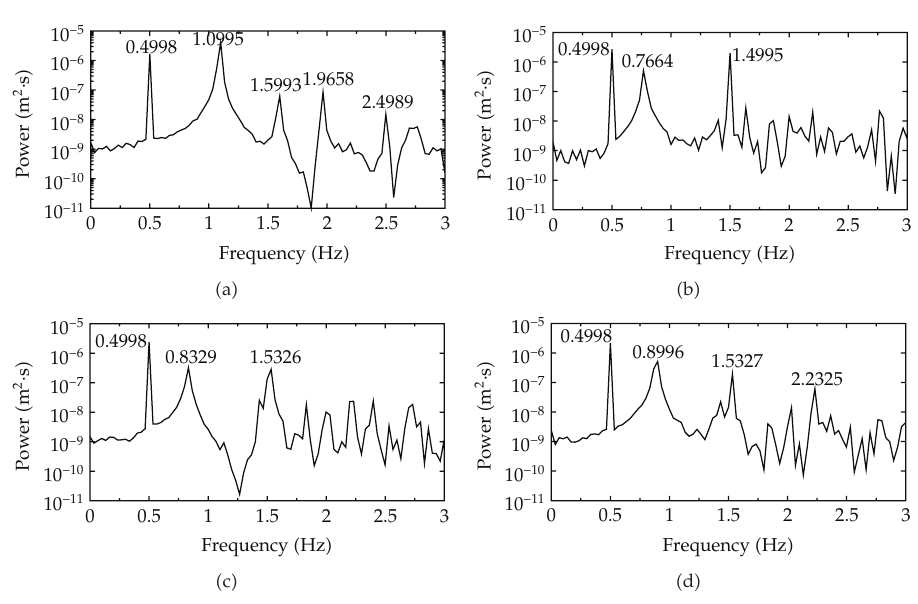
Figure 9: Power spectrum of the free surface elevation at wave gauge G 1 when the excitation frequency is ω (cid:9) π rad/s (cid:6)(cid:6) a (cid:7) without ba ffl e; (cid:6) b (cid:7) b (cid:9) 0mm; (cid:6) c (cid:7) b (cid:9) 40mm; (cid:6) d (cid:7) b (cid:9) 80mm (cid:7)